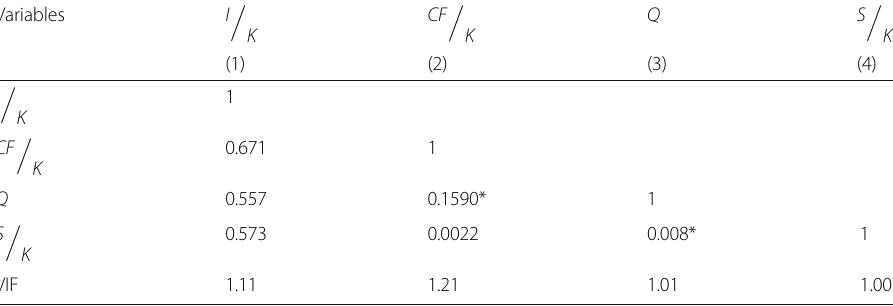
Table 5 Correlation matrix of the key variables